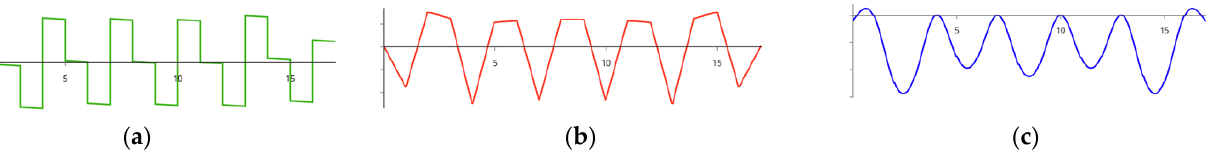
Figure A4. Beam ( a ) shear force diagram, ( b ) bending moment diagram, and ( c ) deflection diagram over the beam length in m. Table A2. Single-span beam load table for London, Ontario. Maximum Component